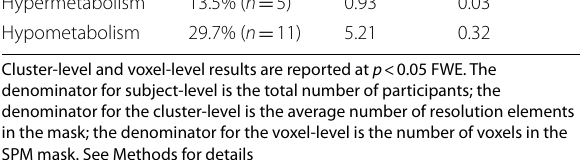
Table 3 % of abnormality in the database